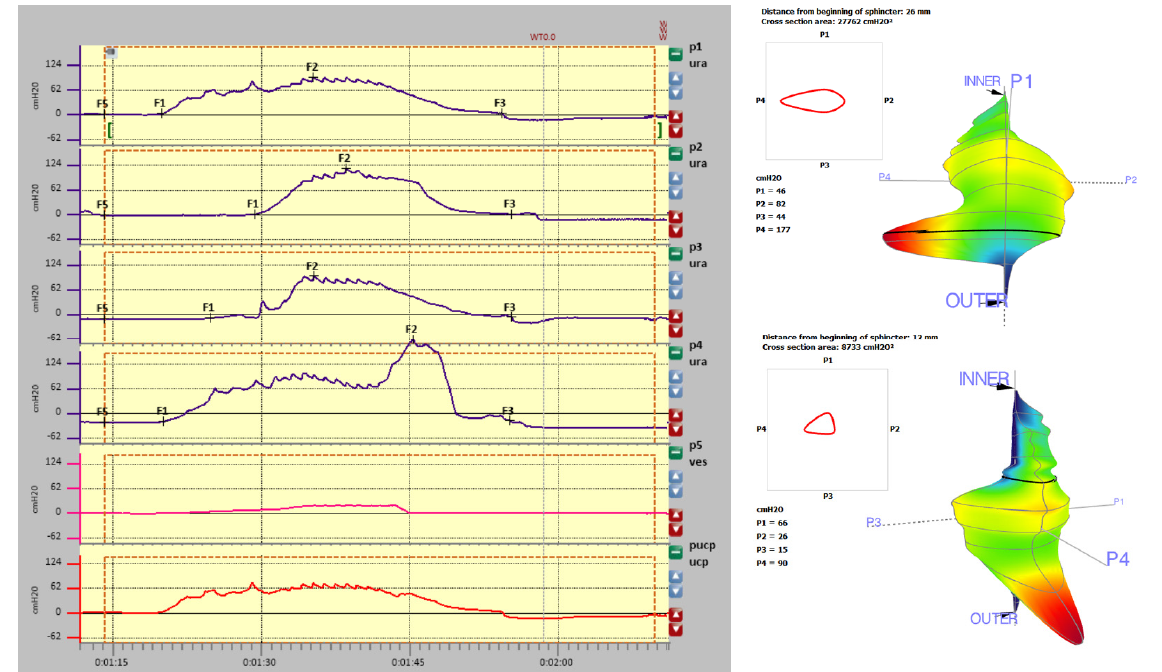
Figure 4. Resting profilometry graphic representation (left side : indyvidual channels measurements, right side-three dimensional reconstruction).